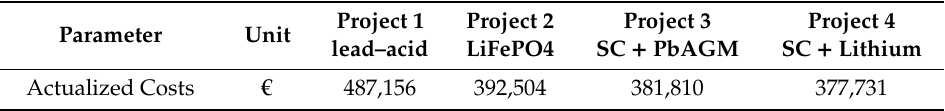
Table 7. Actualized